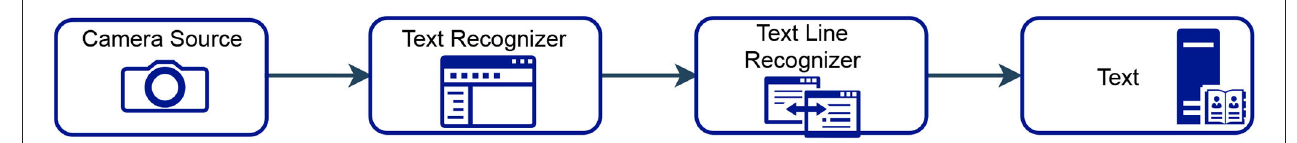
FIGURE 3 | Optical character recognition (OCR) flow diagram.